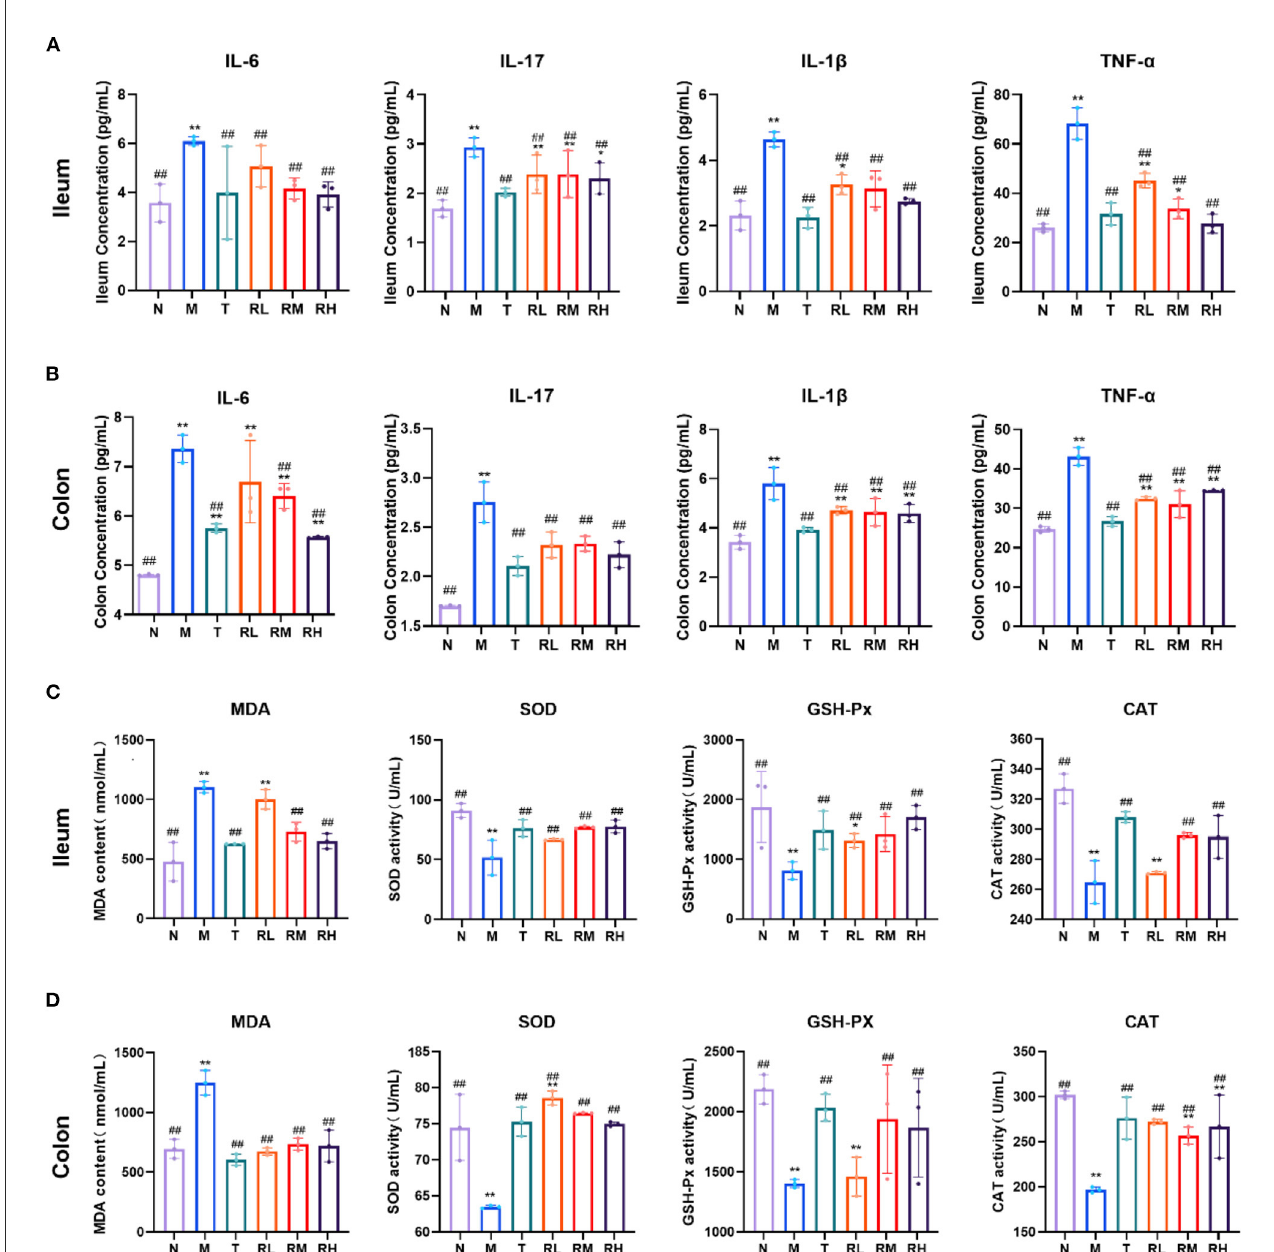
FIGURE4 The effect of RGO on intestinal inflammatory factors and oxidative indexes in LPS mice. (A) IL-6, IL-17, IL-1 β , and TNF- α levels in the ilenm. (B) IL-6, IL-17, IL-1 β , and TNF- α levels in the colon. (C) MDA, SOD, GSH-Px, and CAT levels in the ilenm. (D) MDA, SOD, GSH-Px, and CAT levels in the colon. Compared with group N: * P < 0.05, ** P < 0.01; compared with group M. # P < 0.05, ## P <